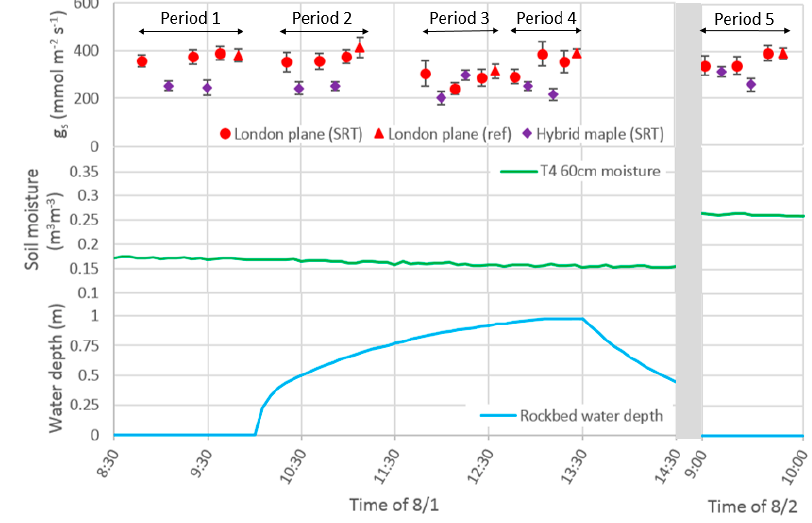
Figure 5. Data collected during and after the simulated runoff test (SRT). Points depict mean (± SE) stomatal conductance (g s ) across repeated measurements in each tree. SRT = trees undergoing the simulated runoff test; Ref = reference trees.